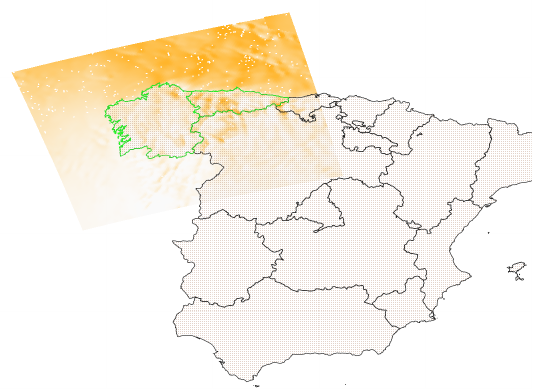
Figure 14. NEWA: Wind power (W/m 2 ) at 75 m. Own elaboration.